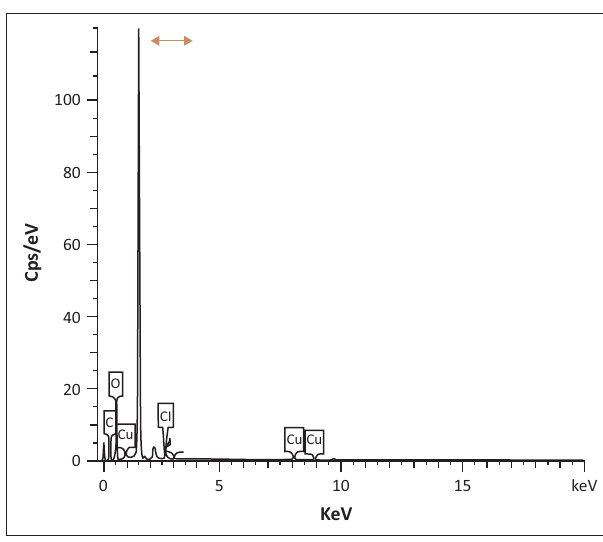
FIGURE 5: Energy-dispersive X-ray microanalysis spectra recorded after formation of silver nanoparticles using Cannabis sativa methanol leaf